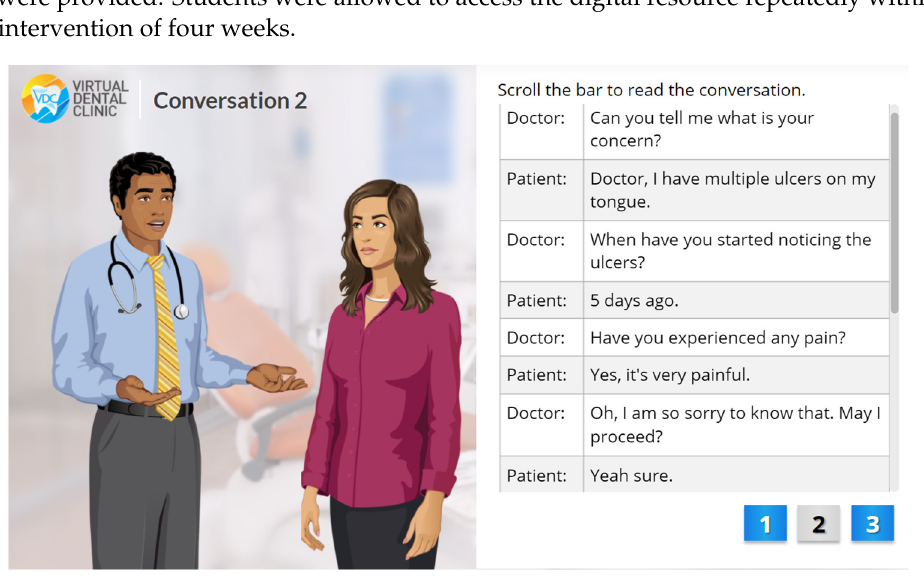
Figure 1. Dentist–patient interaction in history taking.